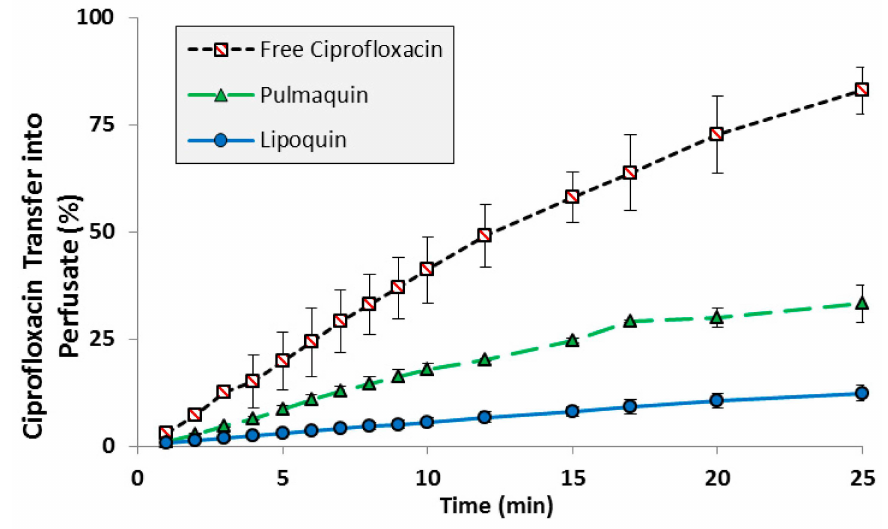
Figure 4. Transport of ciprofloxacin from various ciprofloxacin formulations across an Isolated Perfused Rat Lung. Adapted with permission from [39]. Copyright 2014